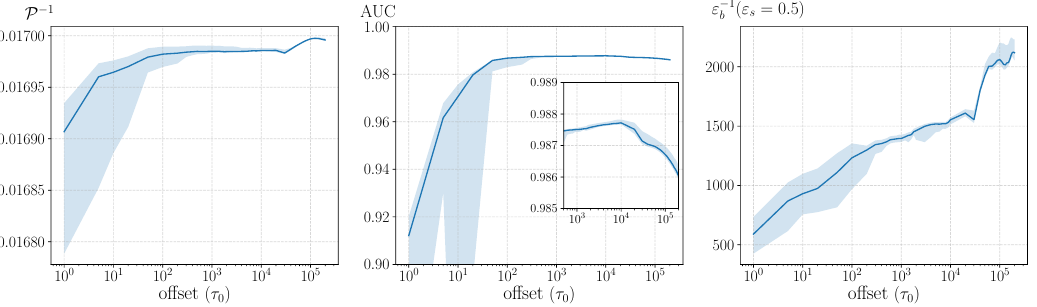
Figure 16 . The inverse perplexity (left), AUC (center), and inverse mistag rate (right) as functions of the o(cid:11)set for an event sample with 10 5 events and a chunk size of 10 4 . The calculations were done for 100 di(cid:11)erent random seeds, the blue lines show the mean of these and the shaded regions cover the upper and lower standard deviations. Separate upper and lower standard deviations are used to show how the actual variances in the performance statistics are typically skewed heavily towards the negative